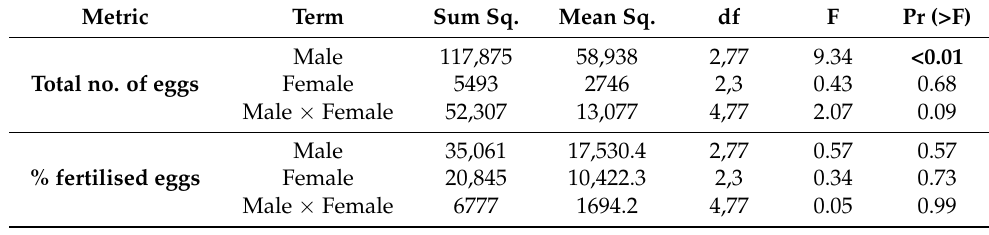
Table 2. Results of fixed effects from linear mixed effects models to test differences in total no. of eggs spawned and percentage of eggs fertilised among different combinations of male and female selections lines. Significant results are in bold.